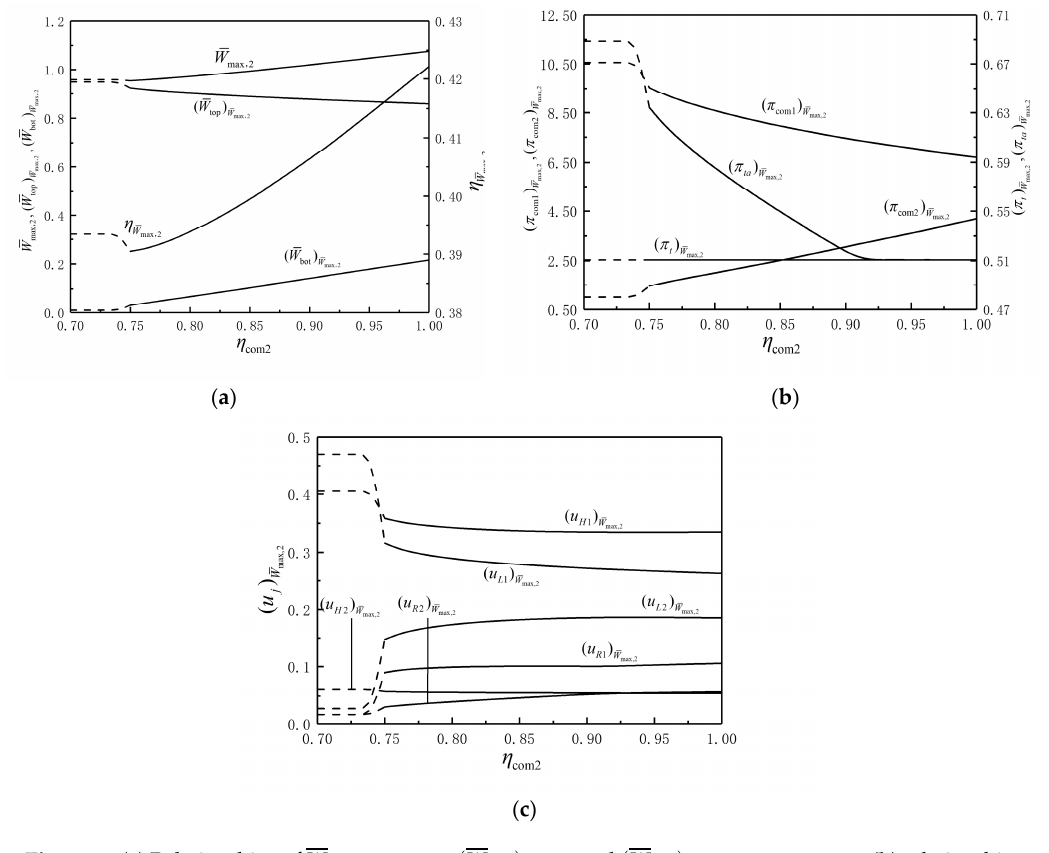
η Figure 8. ( a ) Relationships of Figure 8. ( a ) Relationships of W , ( W top ) and ( W bot ) versus η com2 ; ( b ) relationships max,2 , W max,2 W max,2 W max,2 of ( π com1 ) , ( π com2 ) , ( π t ) and ( π ta ) versus η com2 ; ( c ) relationships of ( u j ) W max,2 W max,2 W max,2 W max,2 versus η com2